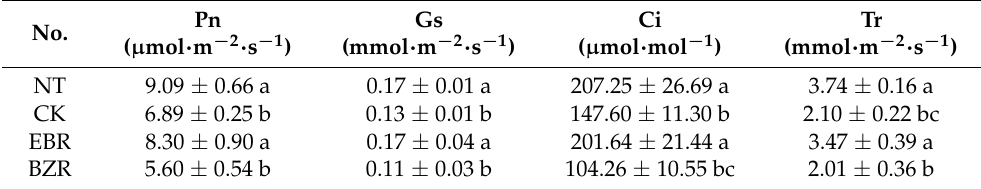
Table 2. Effect of EBR on photosynthesis under low temperature stress in cucumber seedlings.